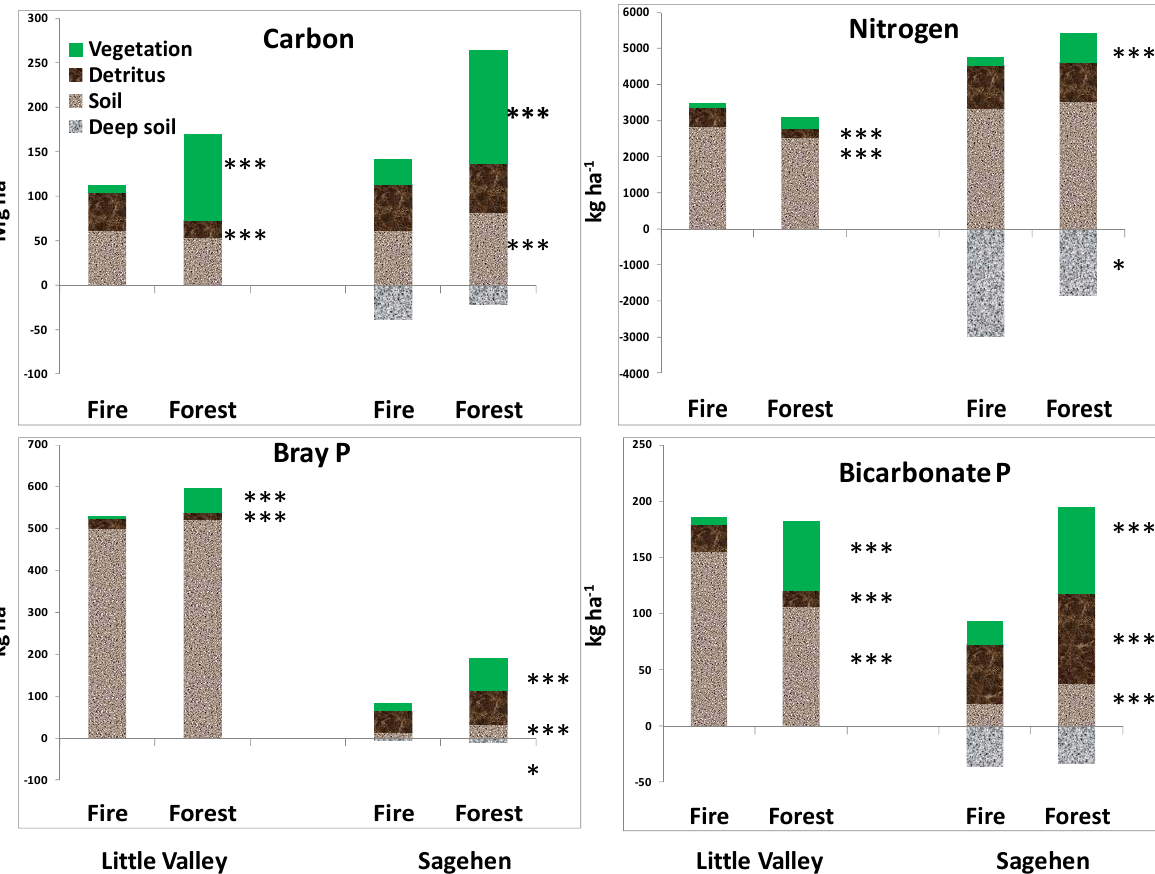
Figure 4. Carbon, nitrogen, and phosphorus distribution in former fire and forest areas of the Sagehen site. Soil Bray and bicarbonate Pare shown separately. *, ** and *** indicate statistically significant differences in vegetation, O horizon, and soil content, respectively. For the Sagehen site, soil values to the 45 cm depth are shown for comparison with Little Valley and soil values to 95 cm are shown separately as negative numbers below the 0